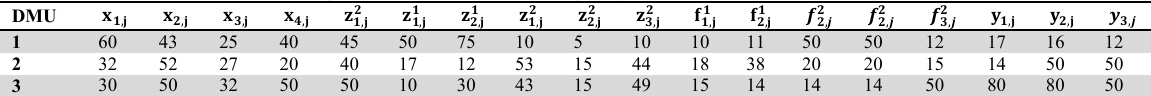
Numerical data for a two-stage model for three-stage system with two